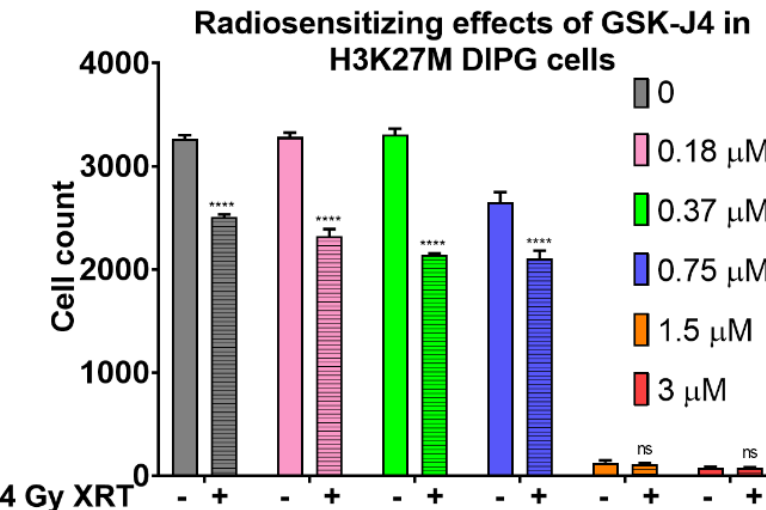
Figure 3. Growth inhibitory and radio-sensitizing e ff ects of GSK-J4 in H3K27M DIPG cells in proliferation assays. Proliferation assay with SF8628 pediatric DIPG cell line harboring the histone H3.3 K27M mutation. The radio-sensitizing e ff ects of GSK-G4 by comparing the cell counts with 4 Gy dose ( + ) of radiation (crossed bars), versus without radiation ( − ) treatment (open bars). The cells were treated with the indicated concentrations of GSK-J4 for 5 days to reverse the global hypomethylation of H3K27, then subjected to 4 Gy dose of radiation (or mock-treated). Ninety-six hours post-treatments, the cell counts were determined and plotted along the Y-axis. **** = p < 0.0001; ns = not statistically significant.